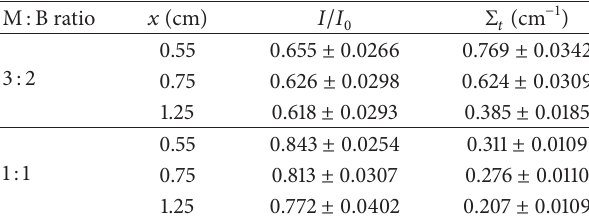
Table 5: Neutron transmission values and the total macroscopic sections of the dehydrated magnesium borate